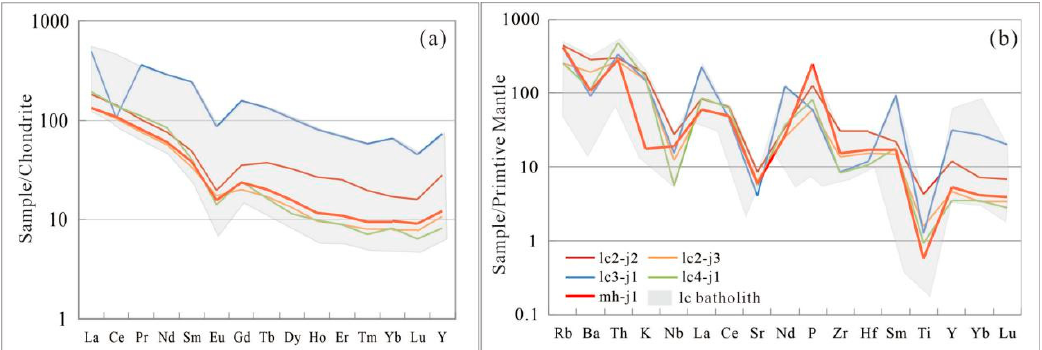
Fig.6 Harker diagrams for the major elements in the Lincang granite Figure 6. Harker diagrams (SiO 2 versus FeO ( a ), MgO ( b ), TiO 2 ( c ), CaO ( d ), MnO ( e ), P 2 O 5 ( f )) for the